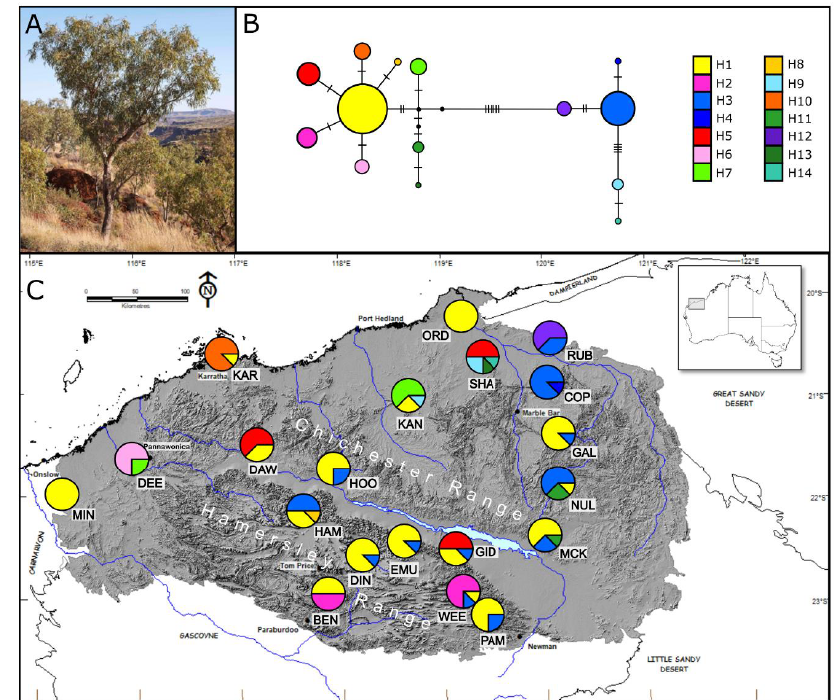
Figure 1. ( A ) C. hamersleyana at East Munjina (EMU); photo credit S. van Leeuwen. ( B ) Network of cpDNA haplotypes identified with frequency indicated by circle size and black dashes representing mutational steps. ( C ) Map of the 20 C. hamersleyana populations with pie charts indicating frequency of haplotypes at each population. Genes 2020 , 11 , x FOR PEER REVIEW